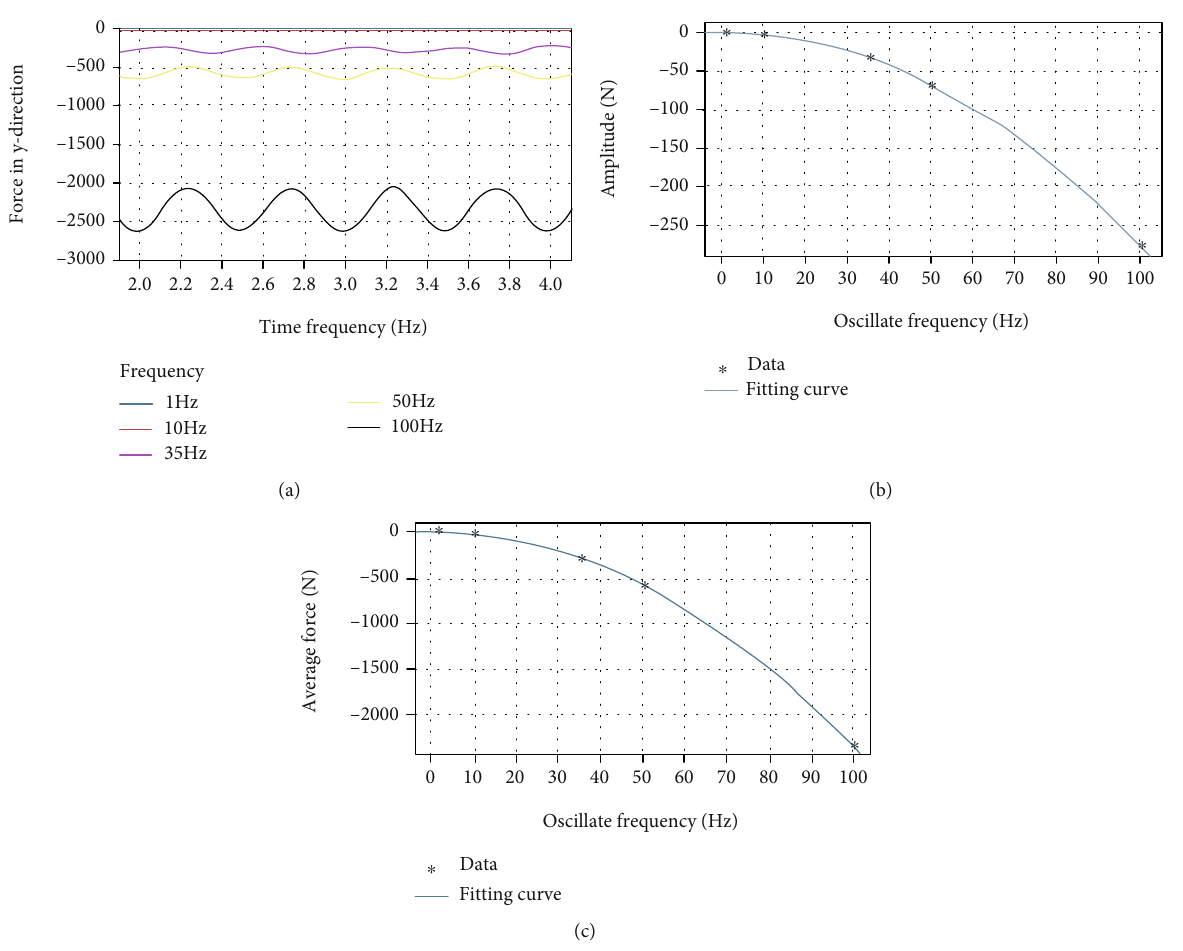
Figure 11: (a) y -direction force on the dorsal fi n at di ff erent frequencies. (b) The relationship between amplitude of force and frequency. (c) The relationship between average value of force and frequency. Table 5: y -direction force parameter values of the dorsal fi n at di ff erent